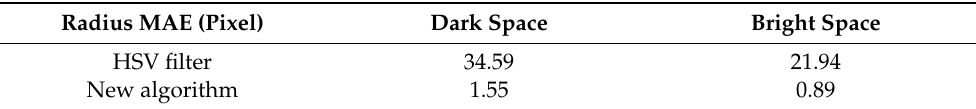
Figure 7. Detection results under harsh lighting conditions. ( a ) Results in a dark space with direc- tional light; ( b ) Results in a bright space with excessive backlight. Table 1. MAE of the HSV Filter and the newly developed